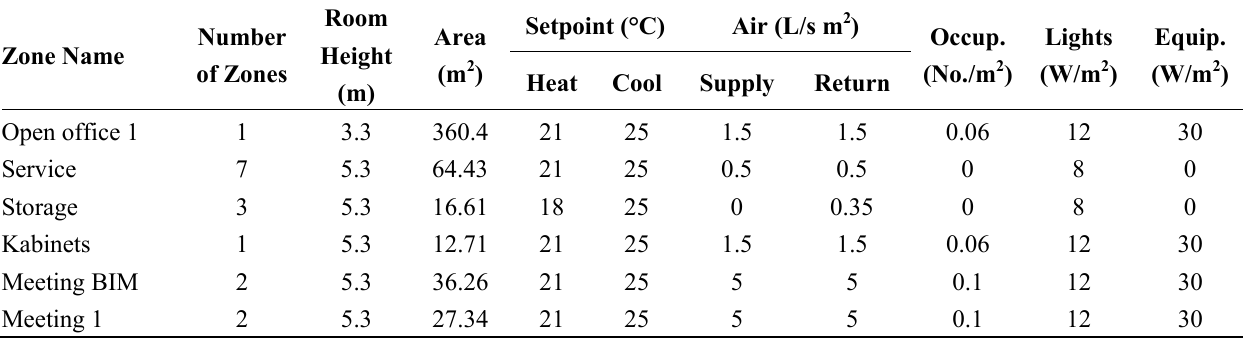
Table 2. Modelled spaces and their internal loads, air flows, heating and cooling set points as well as room area and